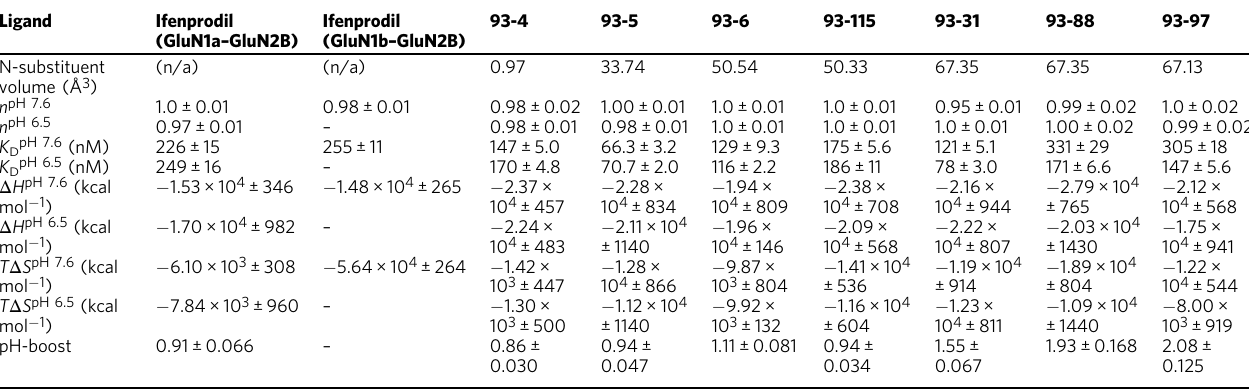
Table 1 Results of ITC experiments titrating the ATD dimer with various